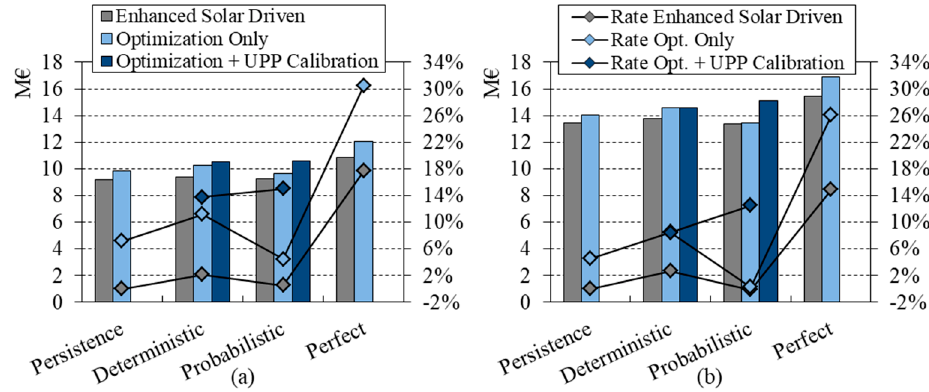
Figure 13. Annual simulated results of financial income for 2016 ( a ) and 2017 ( b ), and improvement rates in comparison to the enhanced solar driven persistence case for each input set.